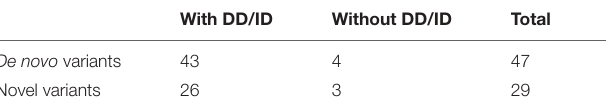
TABLE 2 | Number of de novo and novel gene variants in the patient under 1 year-old.